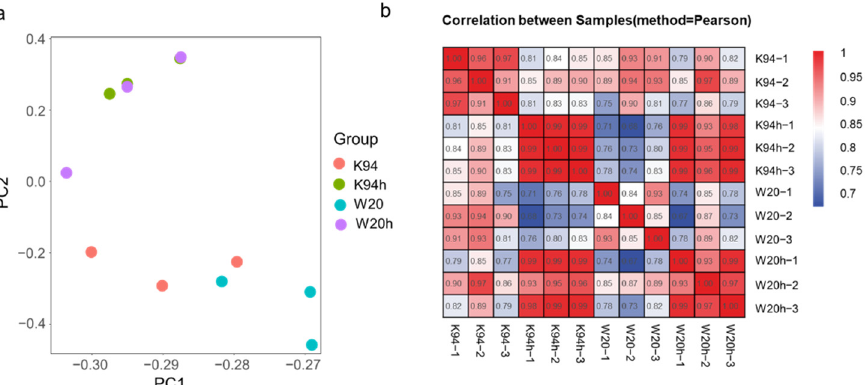
Figure 2. Sample correlations: ( a ) PCA of the samples; ( b ) correlation analysis of the samples. The